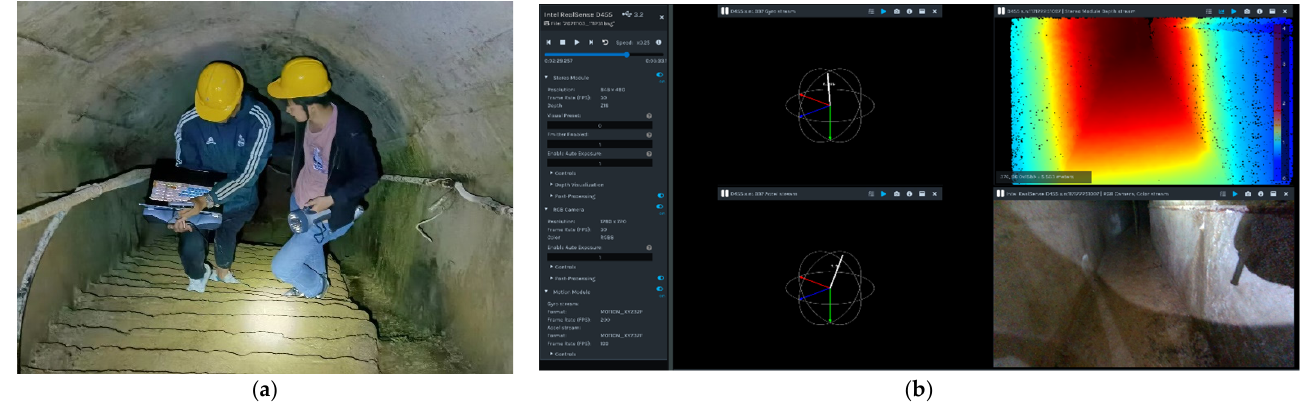
Figure 7. Data acquisition diagram of depth camera. ( a ) Depth camera data acquisition site; ( b ) Offline dataset recorded by Intel Realsense SDK.